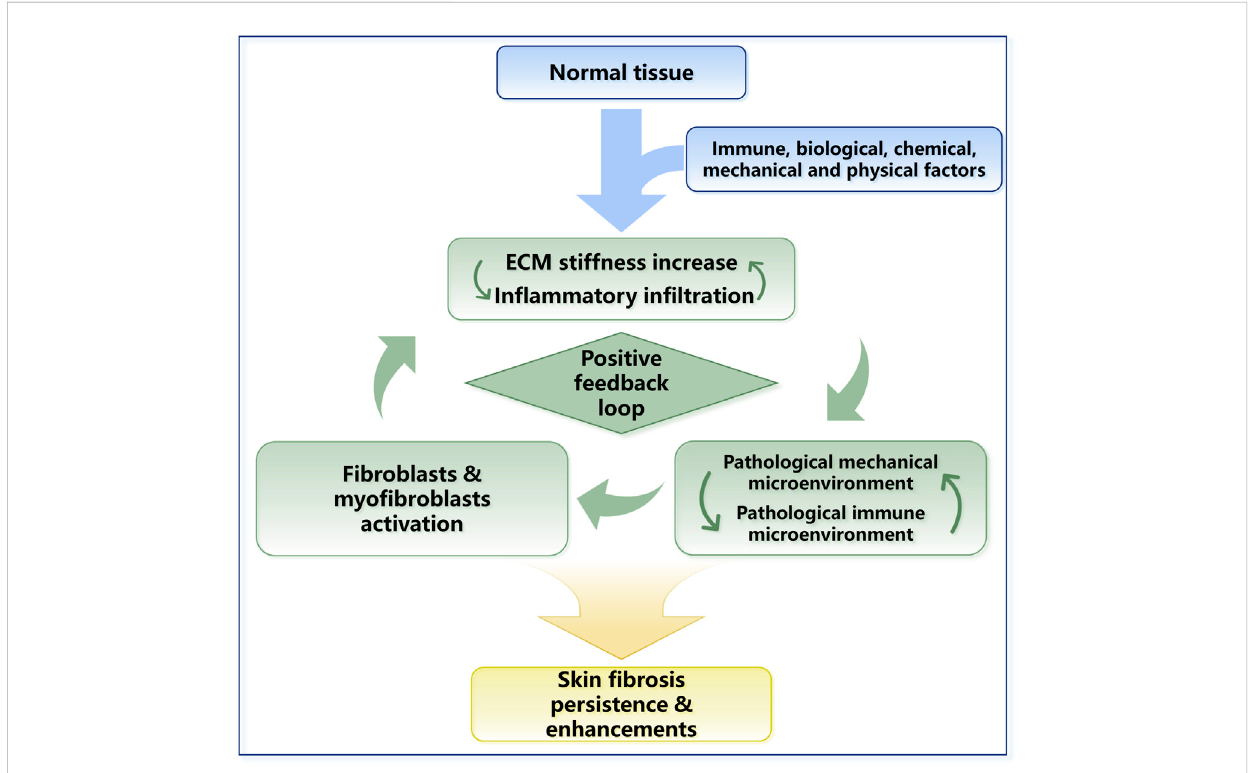
FIGURE 4 The positive feedback loop in skin fi brosis. ECM stiffness changes and in fl ammatory responses work together and lead to skin fi brosis. The mechanical property upregulation leads to the activation of TGF- β and other in fl ammatory factors. In fl ammatory responses and in fl ammatory cell in fi ltration can promote the sedimentation of collagen and other ECM proteins. In general, a positive feedback loop in skin fi brosis is formed, and ECM stiffness plays a central role in this